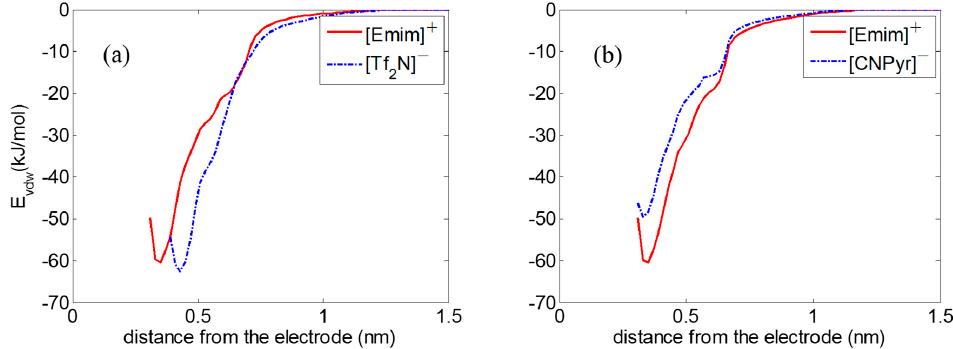
Figure 3. The van der Waals interaction energy between cations/anions and neutral graphene electrode